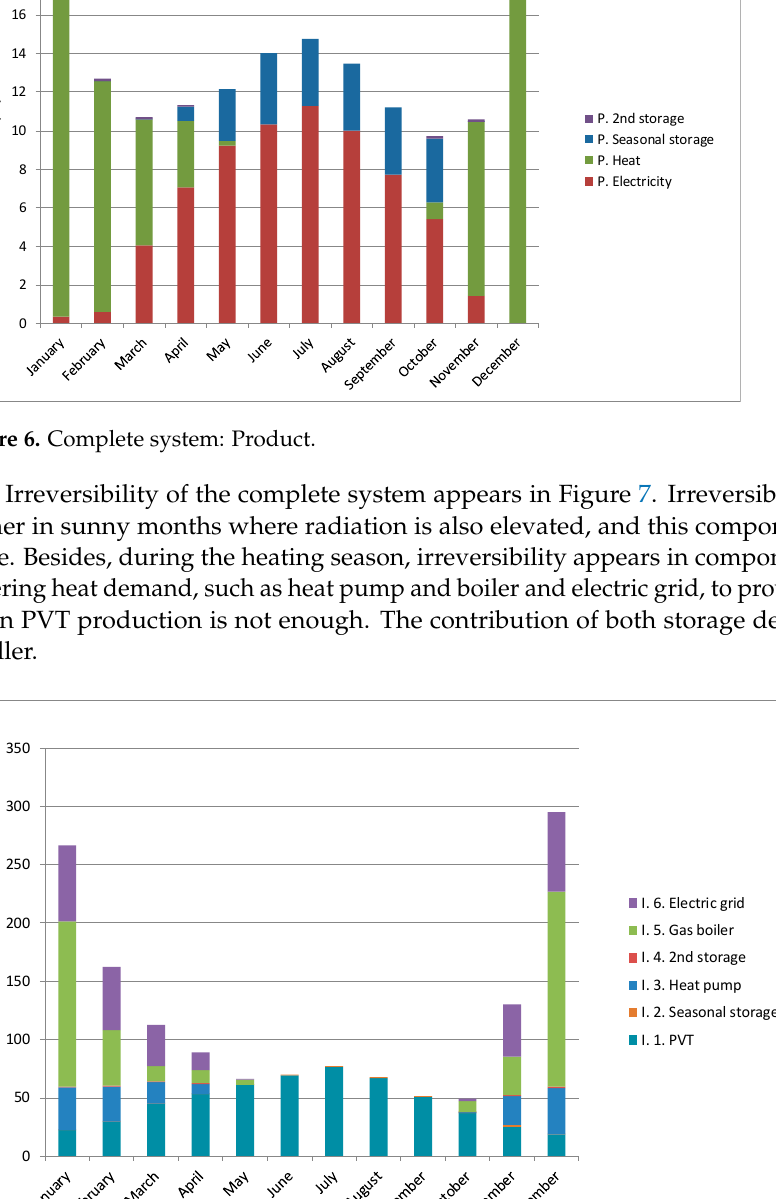
Figure 5. Complete system: Fuel.